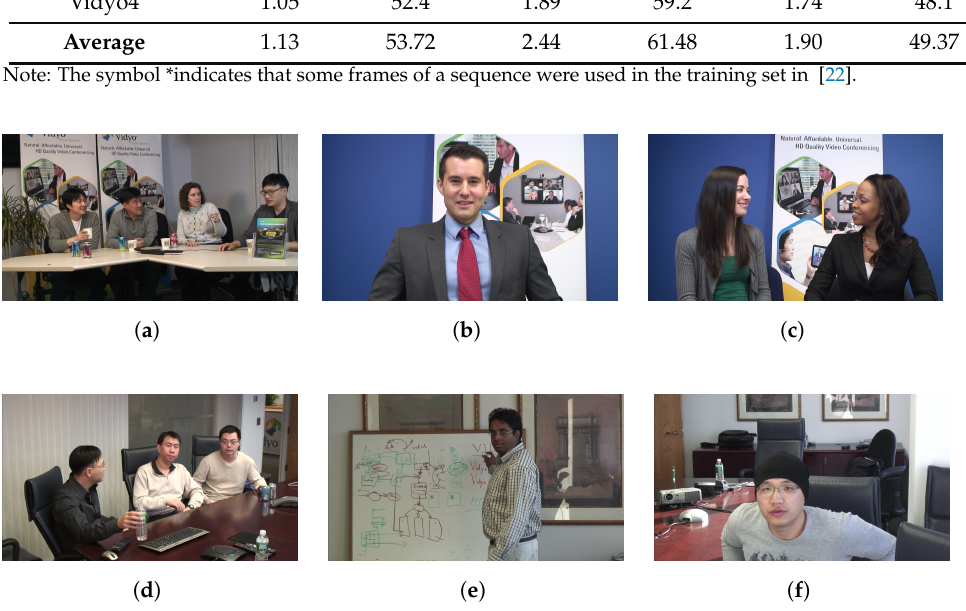
Figure 10. The test sequences. ( a ) FourPeople; ( b ) Johnny; ( c ) KristenAndSara; ( d ) Vidyo1; ( e ) Vidyo3; ( f )